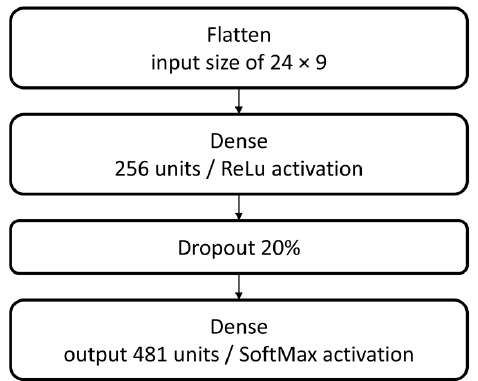
Figure 6. Neural network model.